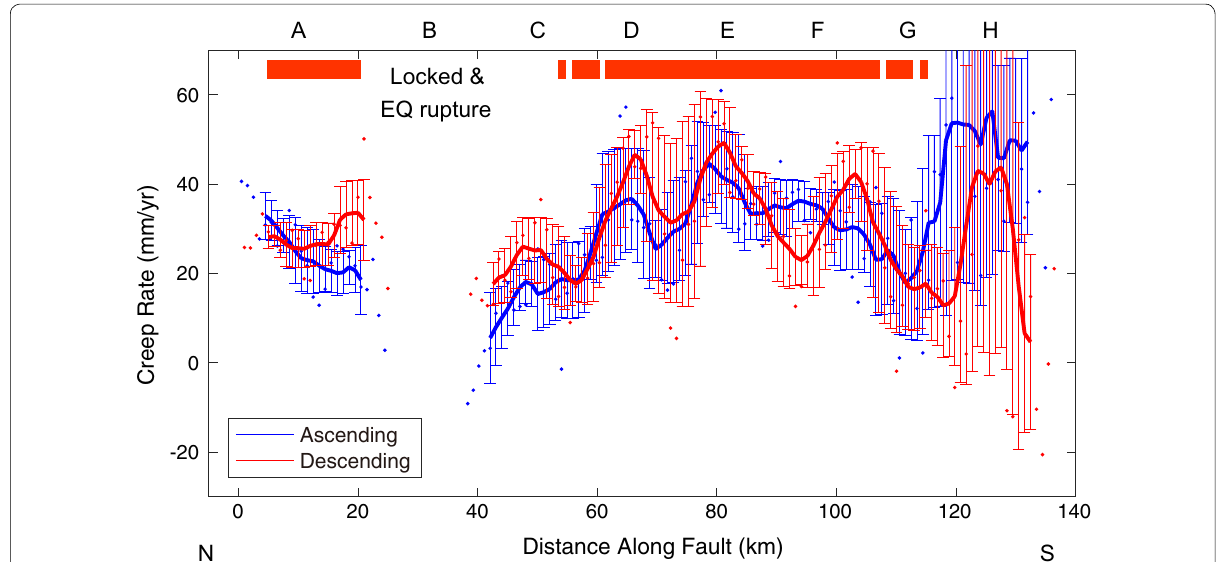
Fig. 9 Creep rates estimated from the average velocity fields in ascending and descending directions. The dots are the creep rate calculated from the offsets on the two sides across the fault. Lines and error bars show the average and standard deviation, respectively, of the creep rate of neighboring five profiles